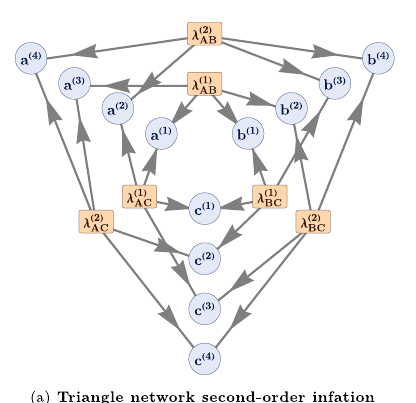
Fig.5|In fl ationtechniqueforthetrianglenetwork.a Thesecondorderin fl ation graph of the triangle network. Such an in fl ation doubles the number of latent variables relative to the triangle scenario, having six latent variables λ ð 2 Þ λ ð 1 Þ λ ð 2 Þ λ ð 1 Þ λ ð 2 Þ g . The in fl ation quadruples the number of observable ran- f λ ð 1 Þ AB , AB , BC , BC , AC , AC dom variables of the triangle scenario, having twelve observable random variables { a (1) , b (1) , c (1) , a (2) , b (2) , c (2) , a (3) , b (3) , c (3) , a (4) , b (4) , c (4) }. Distributions compatible with this in fl ated structure satisfy symmetry properties, and have marginals corresponding to products of triangle-compatible distribution. This can be exploited to derive